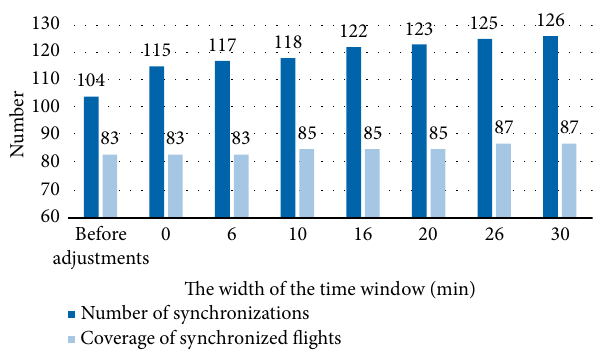
Table 3: Penalties for different v